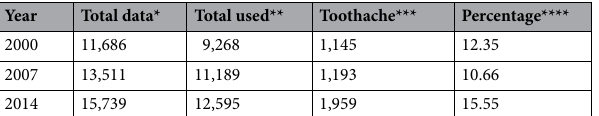
Table 1. Preliminary study of toothache among Indonesia Children from 2000–2014. *All records of toothache observations. **Total records that could be matched to household. ***Number of children with toothaches (within the last month of the survey). ****Percentage/prevalence of children with toothaches.